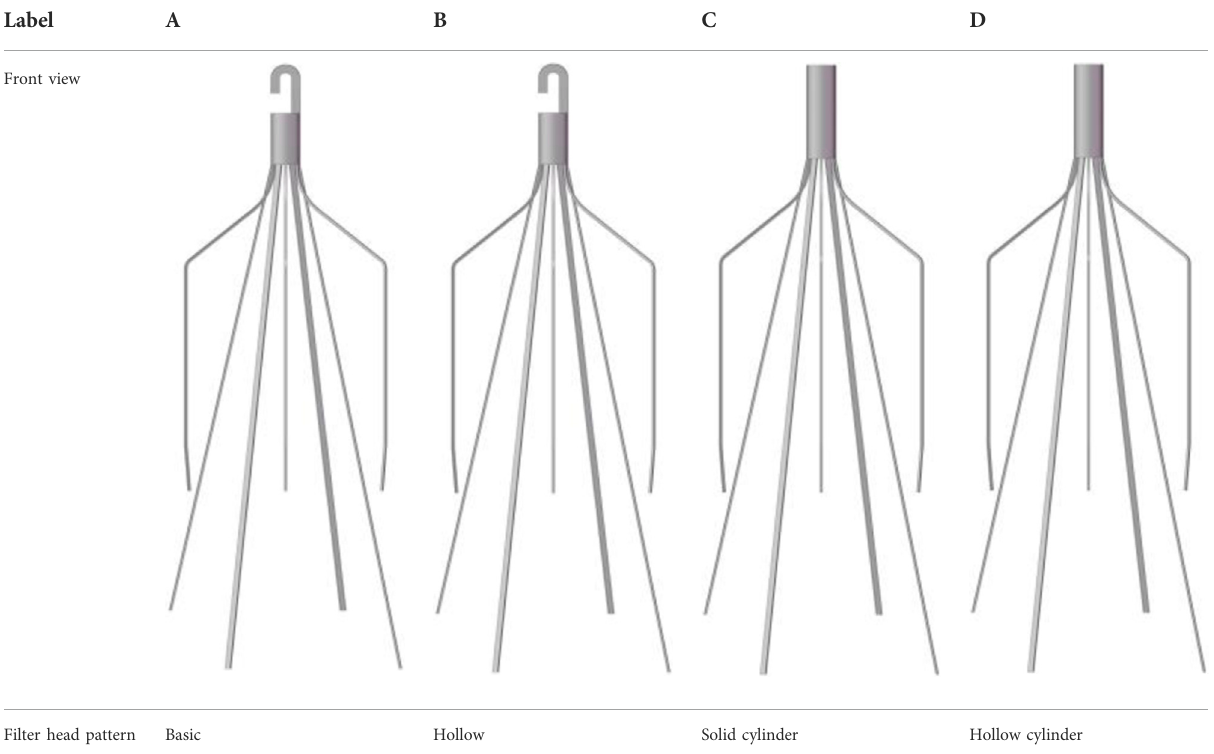
TABLE 1 Four fi lter models for